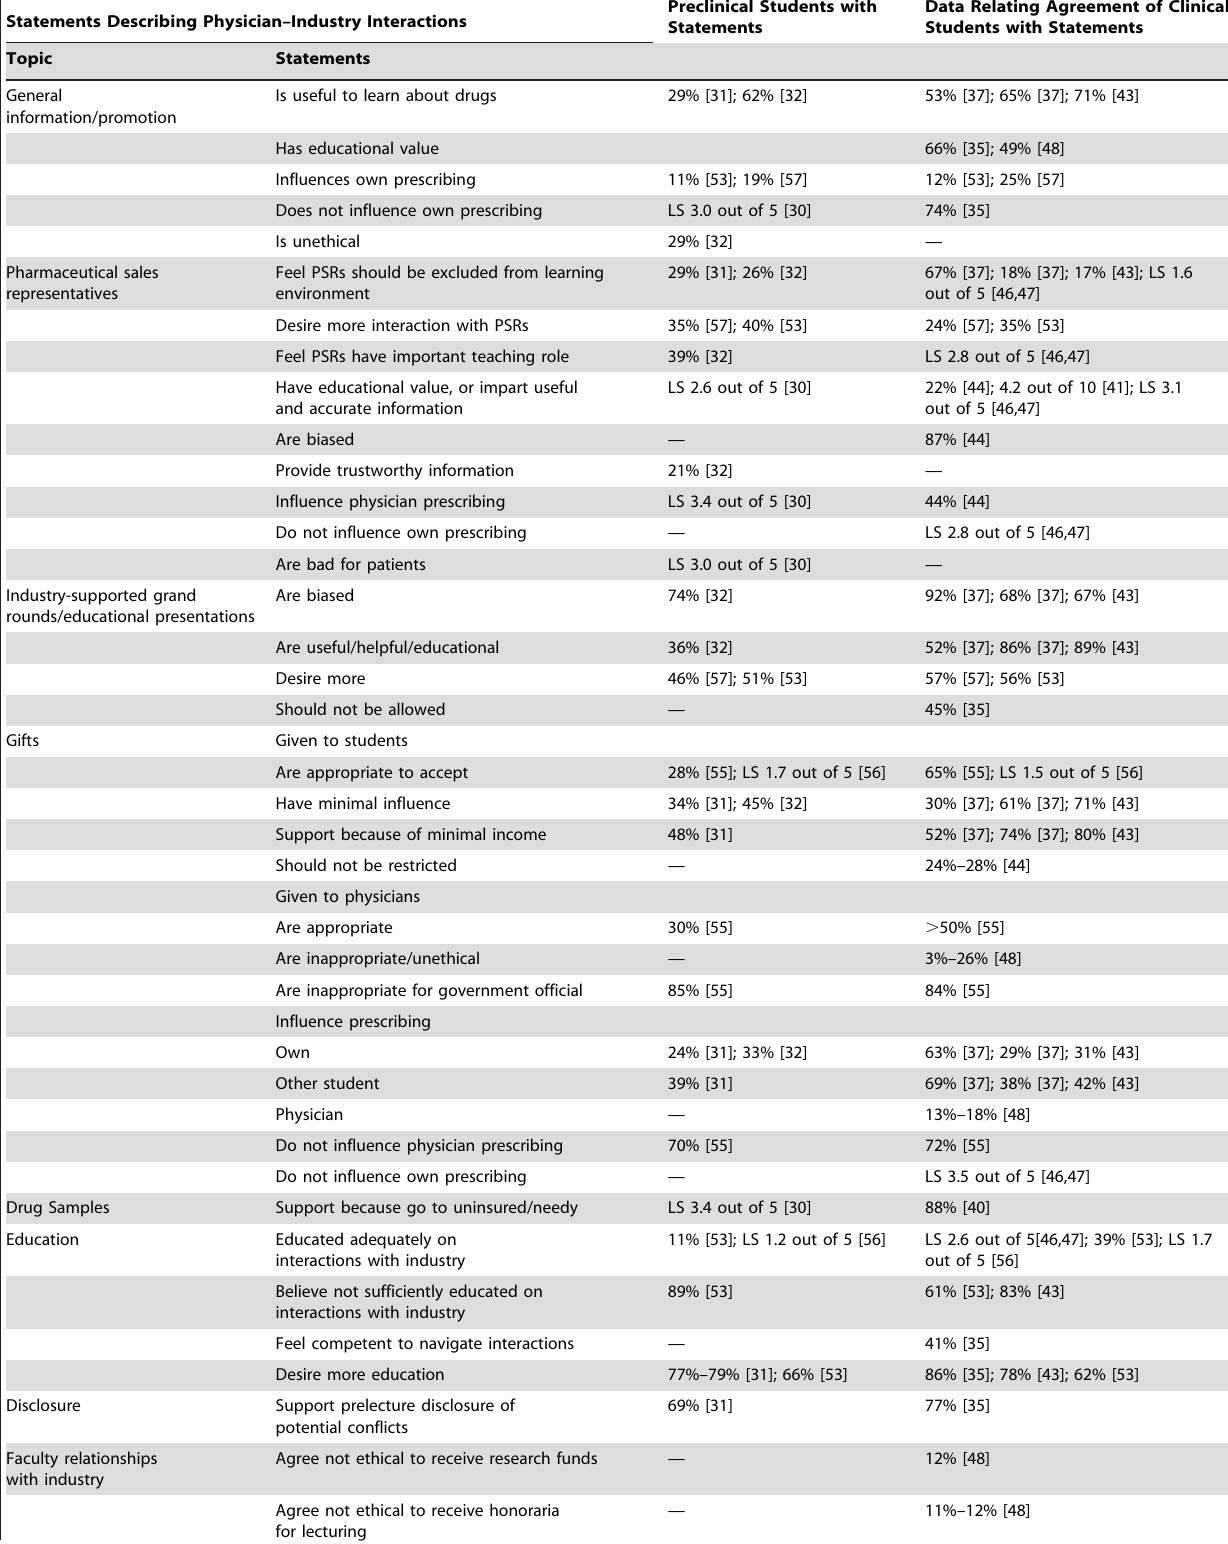
Table 3. Attitudes of preclinical and clinical medical students toward physician–industry